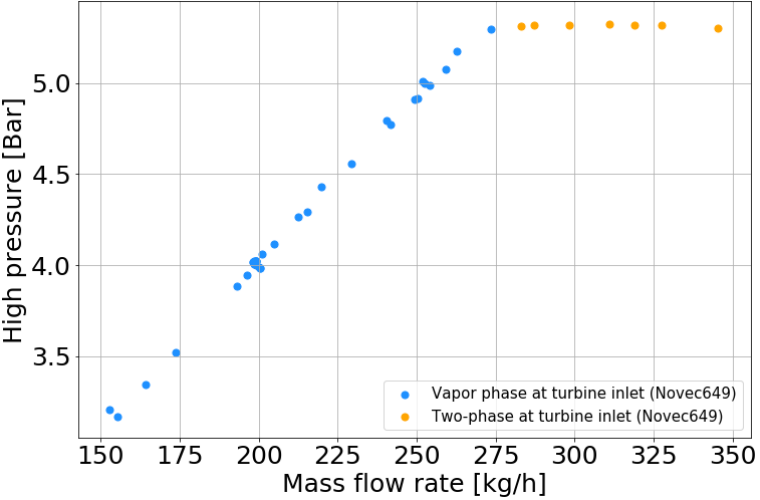
Figure 10. High pressure based on the ORC mass flow rate (Novec649 TM ).